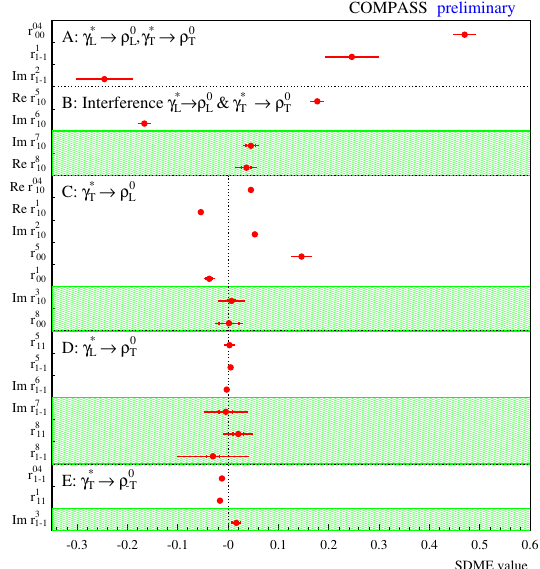
Figure 3: The 23 SDMEs for exclusive ρ 0 leptoproduction extracted for the entire COMPASS kinematic region with 〈 Q 2 〉 = 2.4 (GeV c ) 2 , 〈 p 2 9.9 (GeV c ) 2 . The inter error bars represent statistical uncertainties and the outer ones statistical and systematic added in quadrature. The unpolarised (polarised) SDME are displayed as unshaded (shaded)